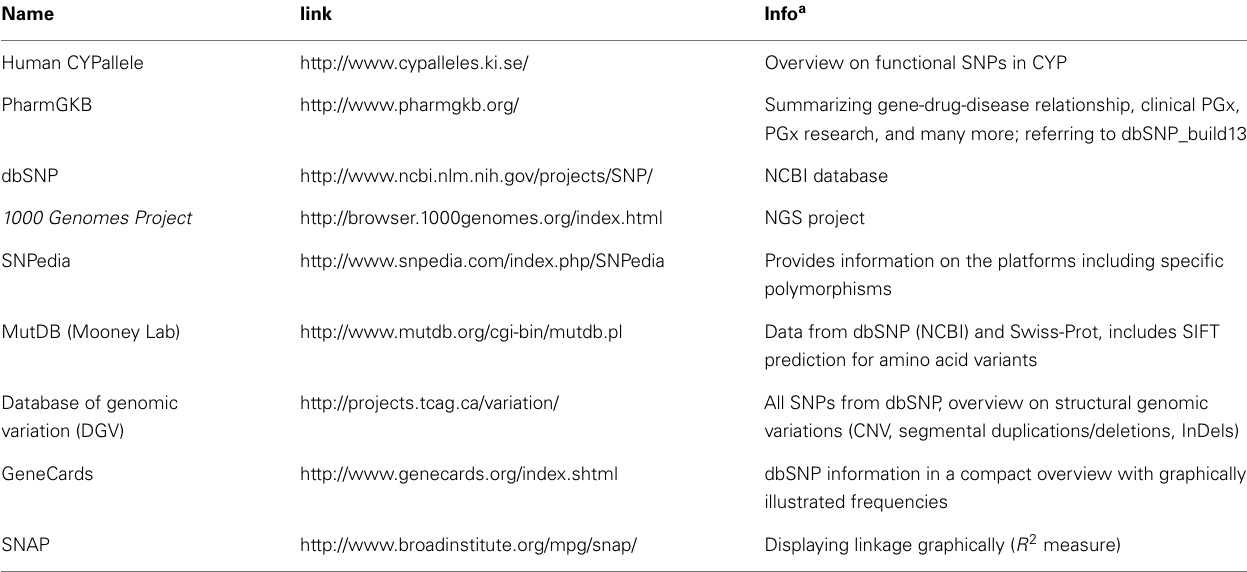
Table 2 | Overview of databases providing valuable SNP/mutation